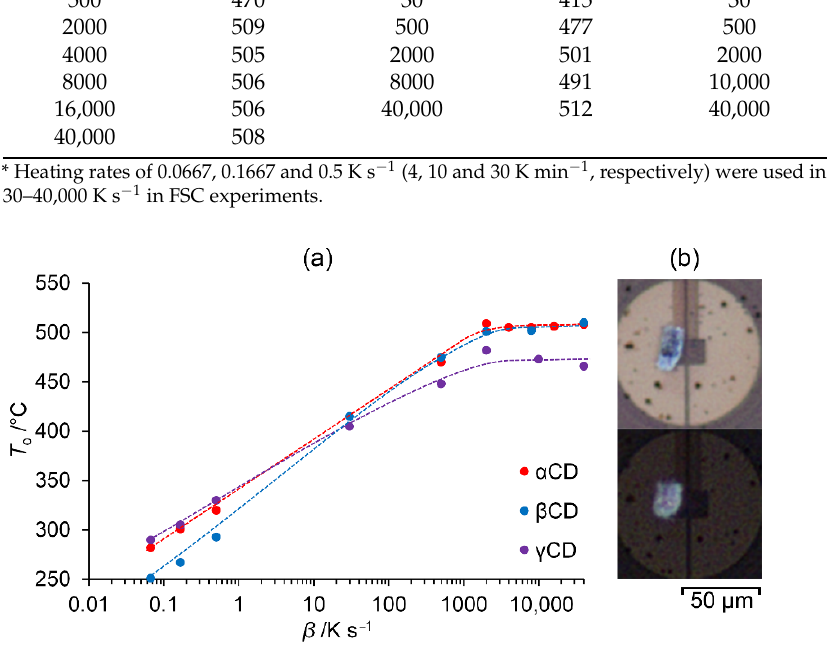
Figure 2. ( a ) Correlation of onset temperatures ( T o ) of main endothermic peak with the heating rate β in DSC and FSC experiments for dry native cyclodextrins (the lines are given to guide the eye); ( b ) the microscope pictures of α CD sample in polarized light before ( upper ) and after ( lower ) melting by heating to 520 °C and cooling to room temperature with the rate of 40,000 K s −1 .